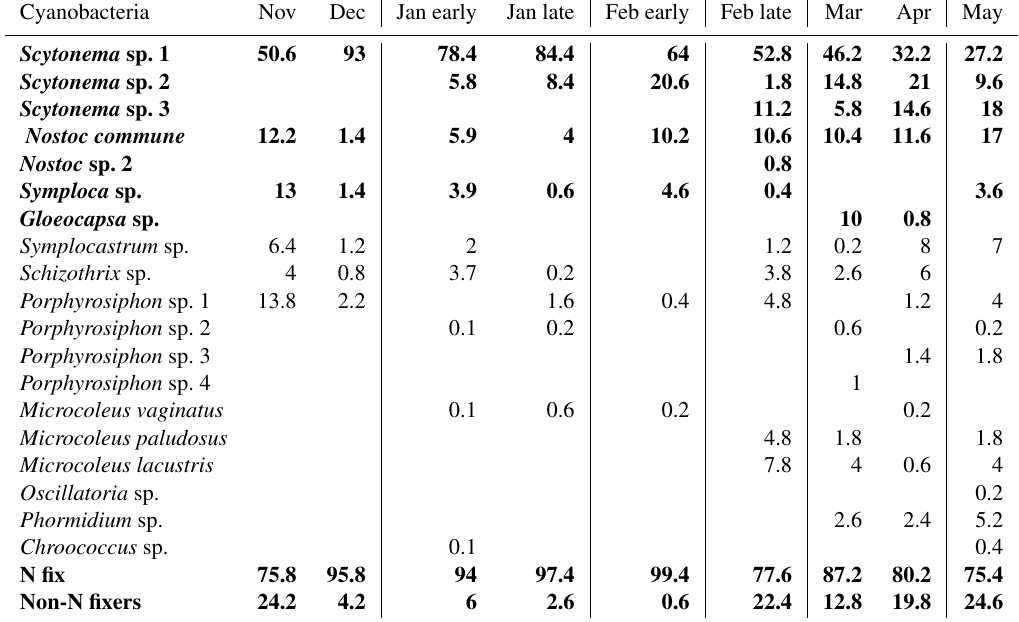
Table 1. Cyanobacterial species richness and abundance over 7 months (nine time periods) expressed as a percentage. N-fixing species (bold) were shown only if they produced heterocytes although we also determined (see main text) several non-fixing species were associated with N enrichment.